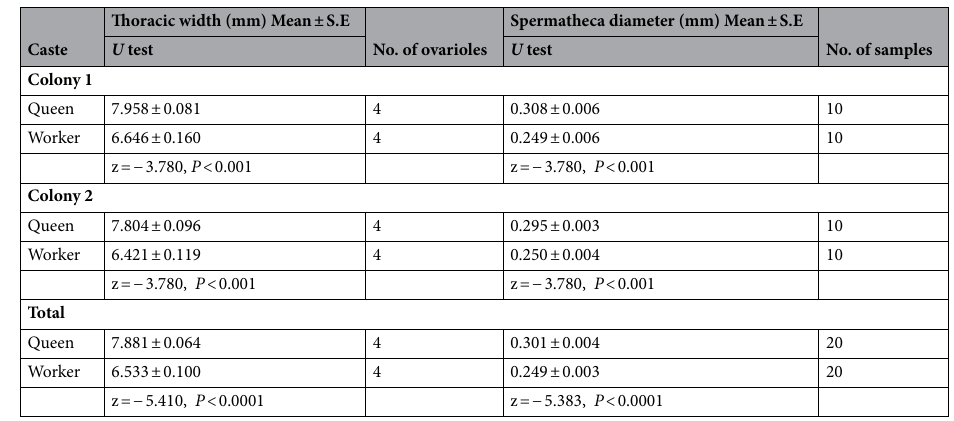
Table 1. Caste differences in thoracic width and reproductive organs in Bombus ignitus